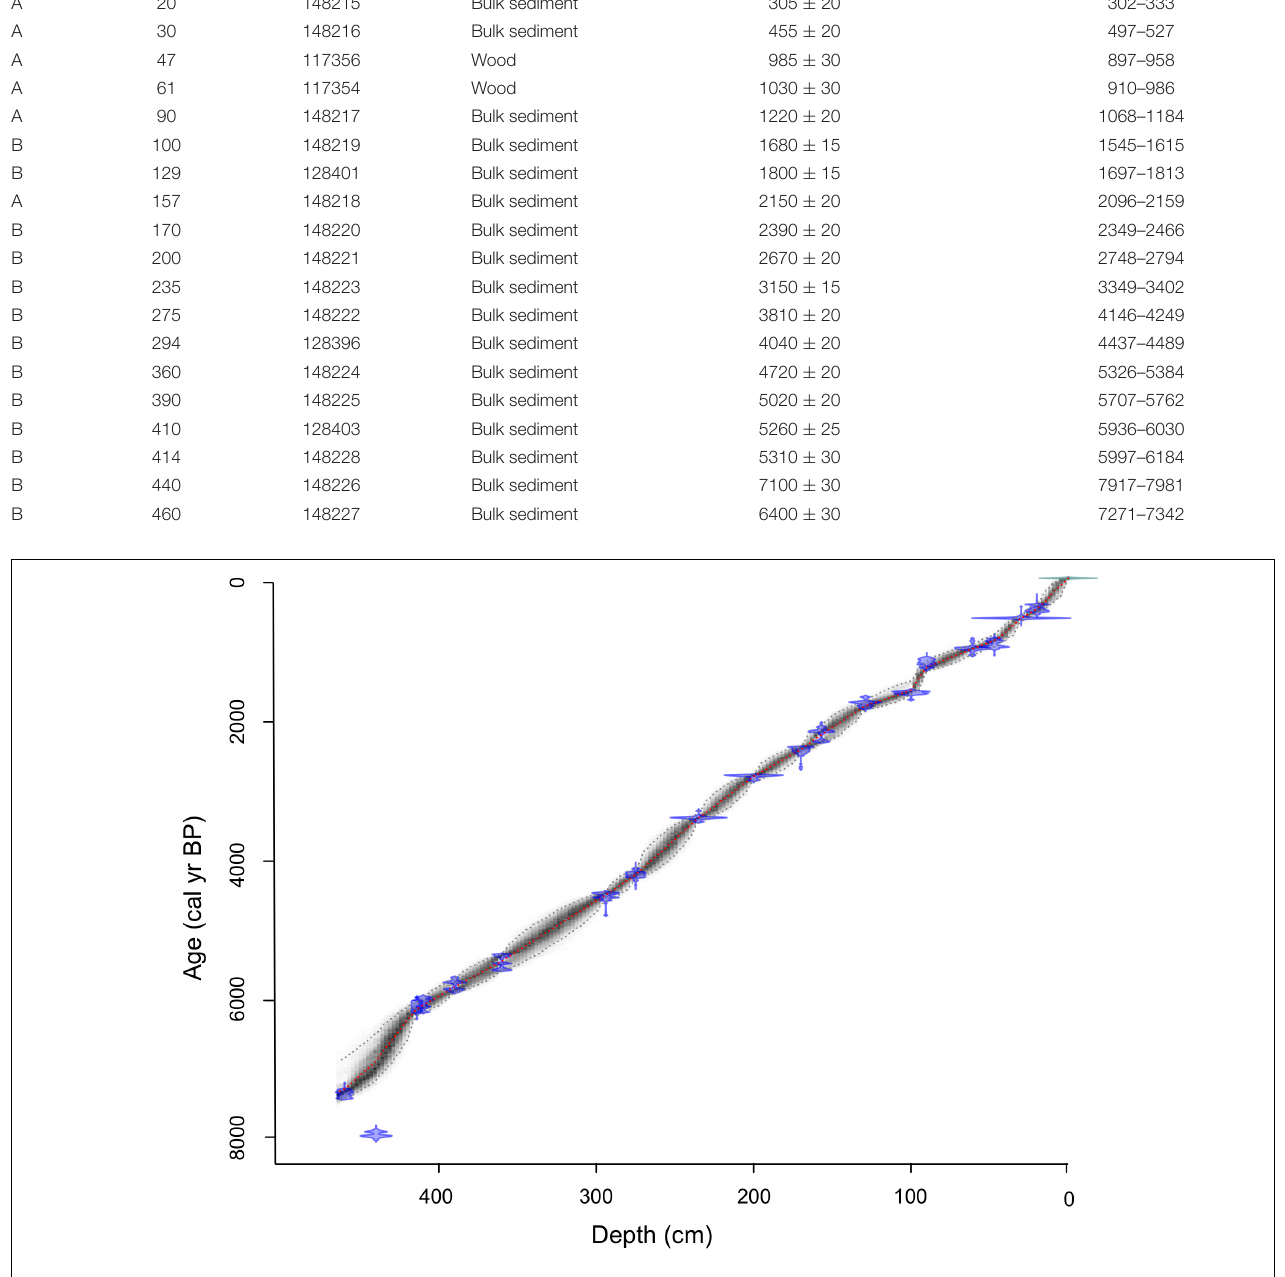
FIGURE 2 | Age-depth model for Black Lake using Bacon age-depth modeling software (Blaauw and Christen, 2011) in R (R Core Team, 2015).